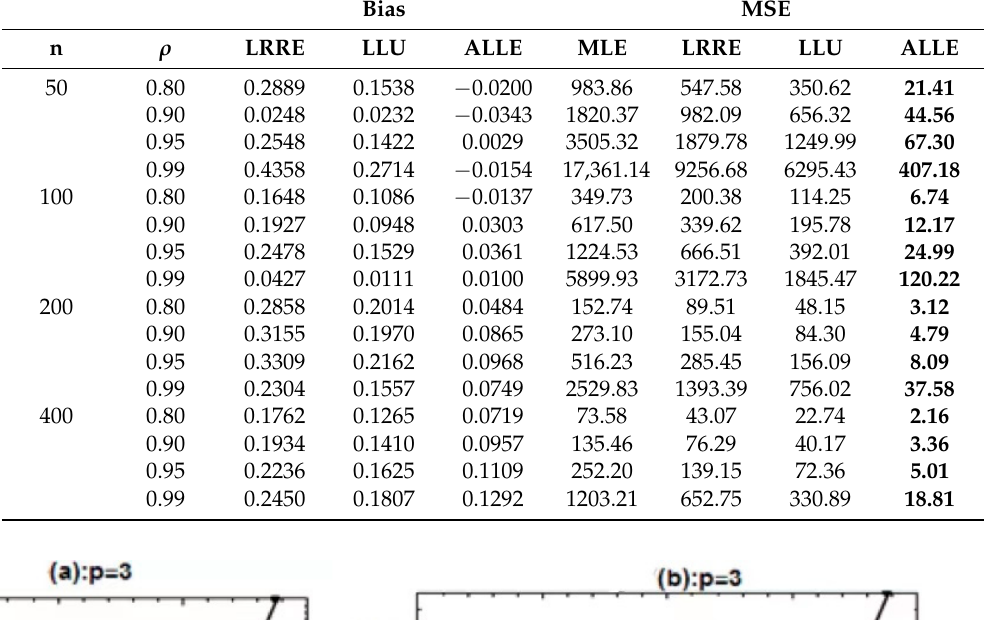
Table 2. Bias and MSE values of the estimators for p = 6.